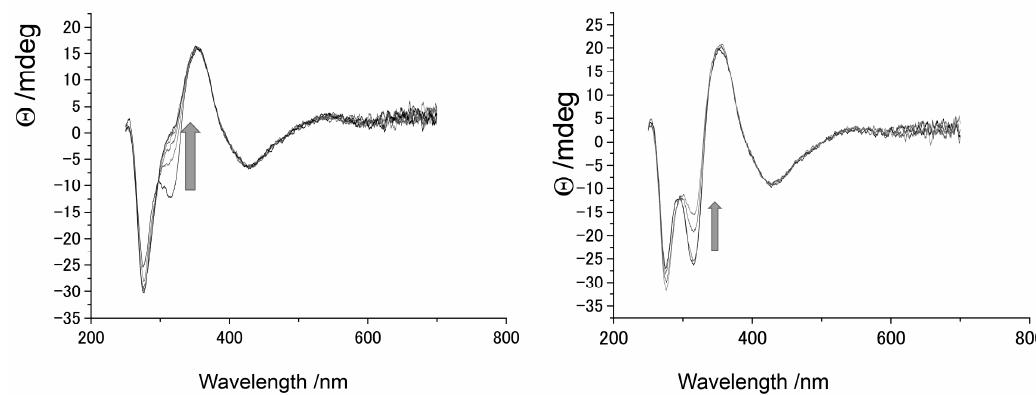
Figure 1. The time change of the ECD spectrum of a methanol solution containing [{ Λ - Figure 1. Ru(III)(acac) 2 (taet)} 3 Al(III)] at room temperature ( left ) and 0 °C ( right ). The spectra were recorded at 3, 5, 8, 10, 13, and 15 min (upper) and 3, 8, 30 and 50 min (lower) after dissolving the solid.